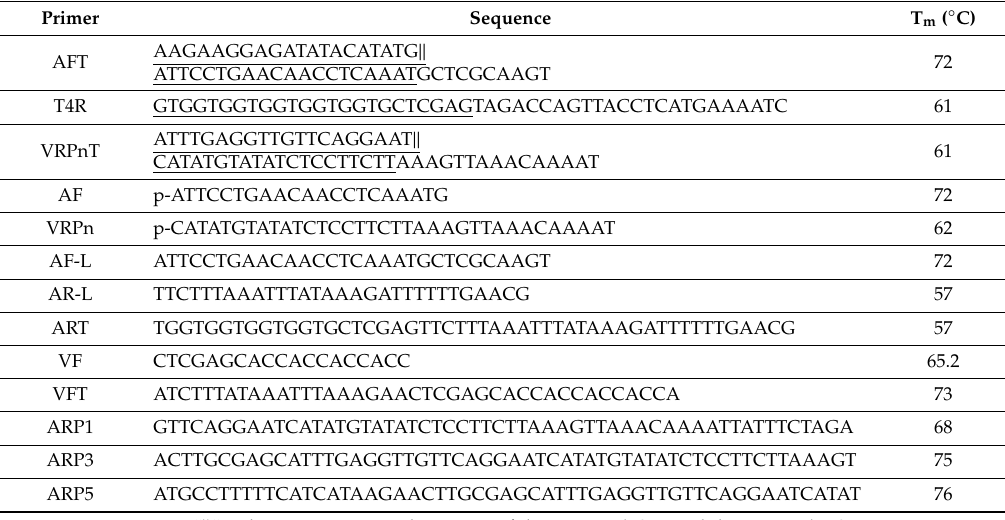
Table 2. Primer sequences and melting